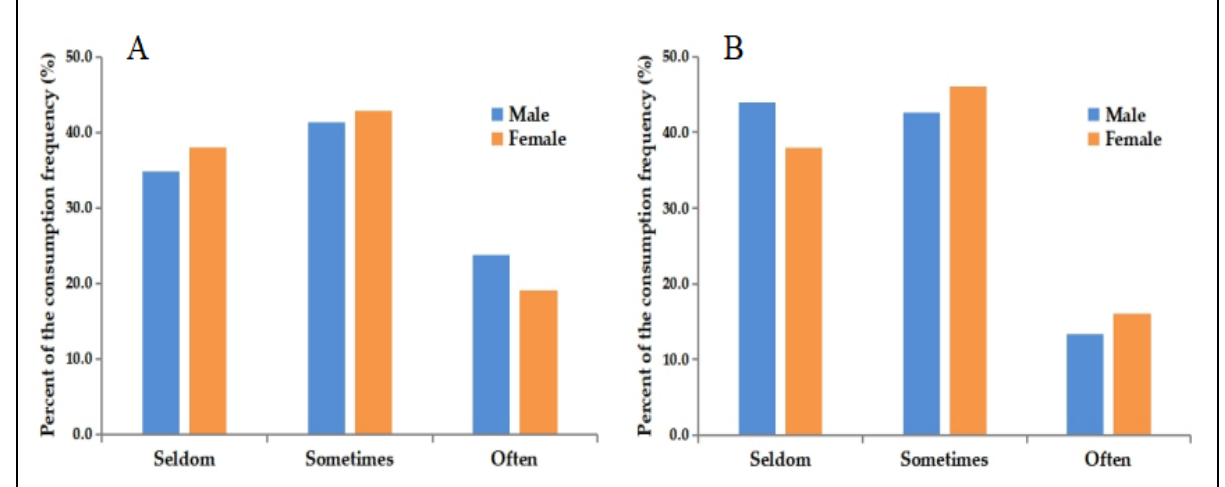
Figure 1. The percent of the consumption frequency of SSBs and high-energy diets in male students and female students. ( A ) The data represent SSB consumption frequency. ( B ) The data represent high-energy diet consumption frequency. Table 2. Description of the academic performance of these junior school